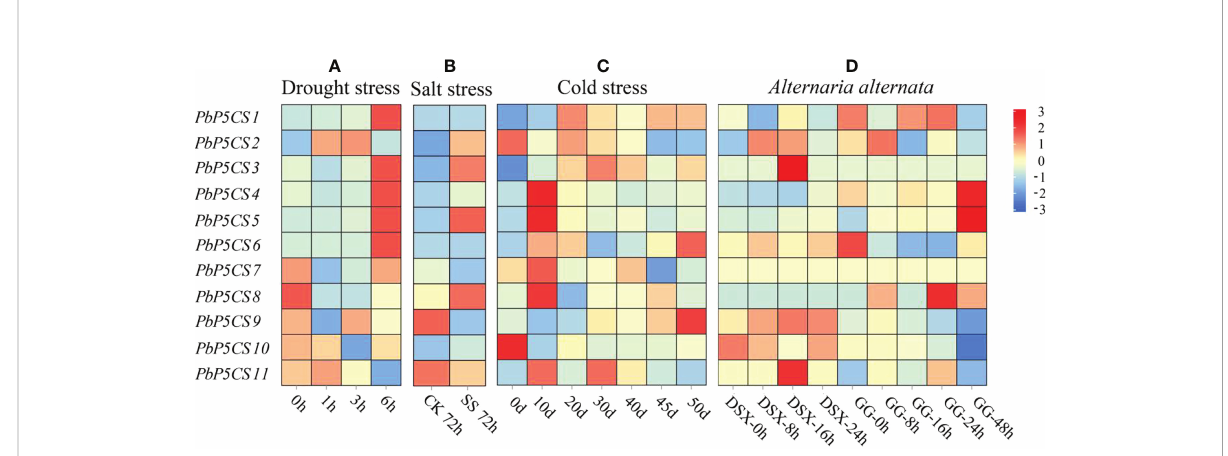
FIGURE 7 Expression patterns of PbP5CS genes in response to abiotic and biotic stresses. (A) Gene expression patterns in Pyrus bretschneideri at 1, 3, and 6 hours of drought treatment (GEO series SRP148620). (B) Gene expression patterns in Pyrus betulifolia at 72 hours of salt stress treatment (GEO series SRP077703). CK, control; SS, salt stress treatment. (C) Gene expression patterns in Pyrus bretschneideri ‘ Suli ’ at 0, 10, 20, 30, 40, 45, and 50 days of cold treatment (GEO series SRP287704). (D) Gene expression patterns in Pyrus pyrifolia ‘ Deshengxiang ’ (DSX) and Pyrus pyrifolia ‘ Guiguan ’ (GG) at 0, 8, 12,16, 24, and 48 hours post-infection by Alternaria alternate (GEO series SRP276846). Data are expressed as fragments per kilobase of exon per million mapped reads. Blue and red blocks indicate decreased and increased transcription levels,